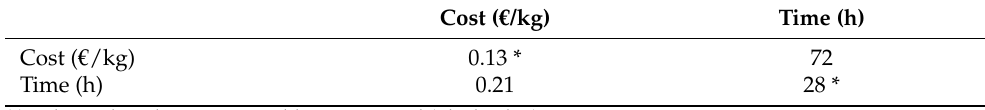
Table 3. Values to create the matrix of payments between cost and